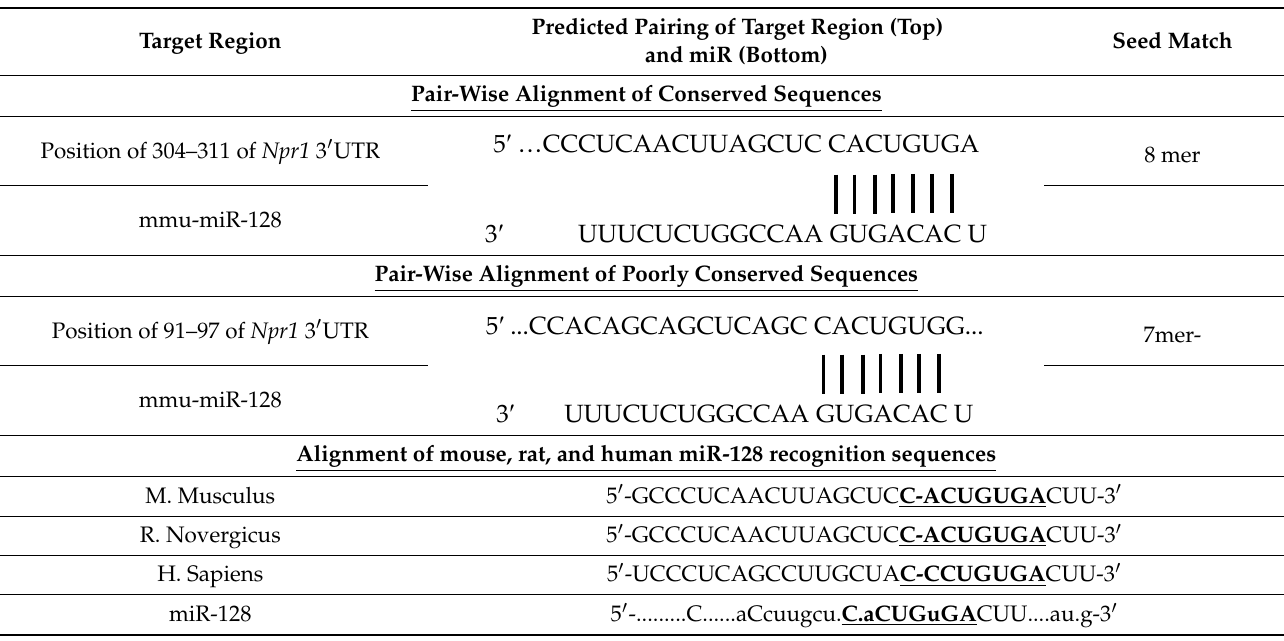
Table 1. MiR-128 binding to mouse Npr1 3 ′ UTR and comparison of miR-128 seeding sequence to the Npr1 3 ′ -UTR of mouse, rat, and human genes. Predicted Pairing of Target Region (Top) and miR (Bottom)